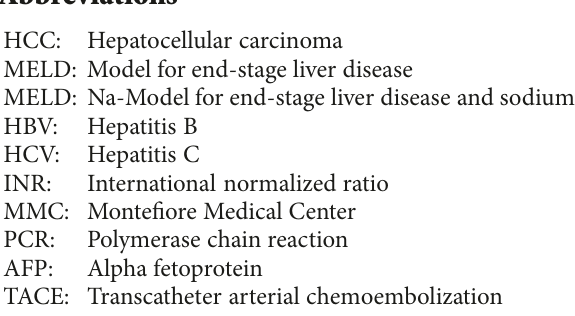
Table 1. Cause of death grouped by MELD-Na increase cutoff of 40%. (Supplementary